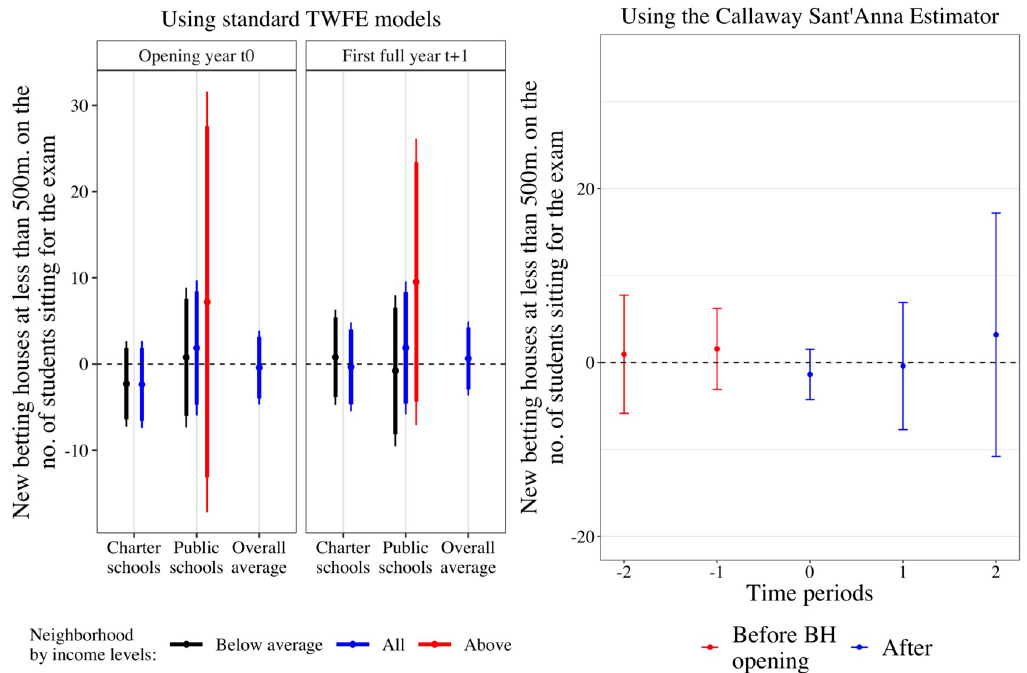
Fig 5. Alternative explanation: Compositional change. Betting houses effect on the no. of students. Note: The figure shows a replication analysis of Figs 2 and 4 but replacing this paper’s primary outcome with the number of students sitting for the exam. Notice that an adverse effect would inform that students sort out from high schools with close-by betting houses—the negative effect on academic performance would come from a compositional change.